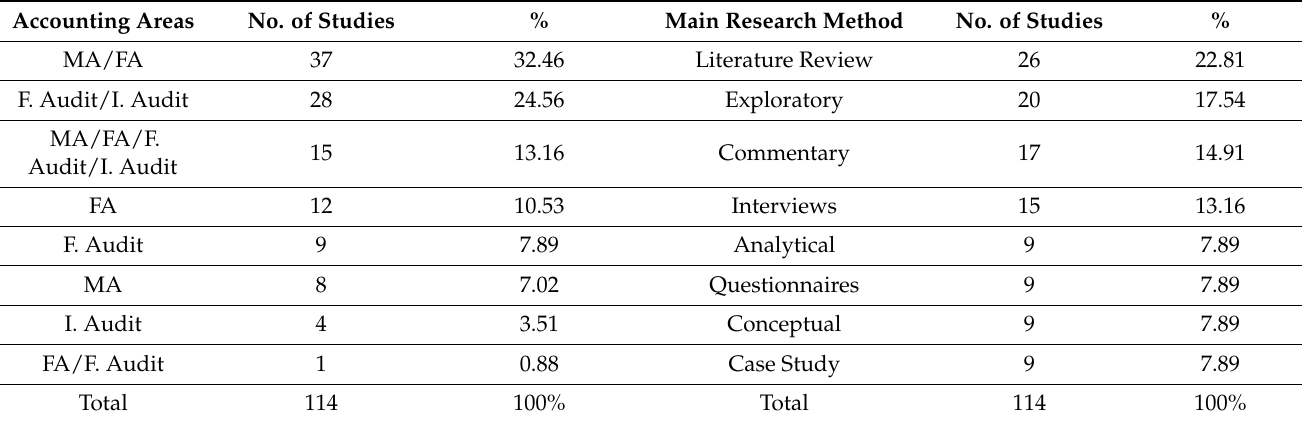
Table 3. Percentual results of literature overview. (Source: authors’